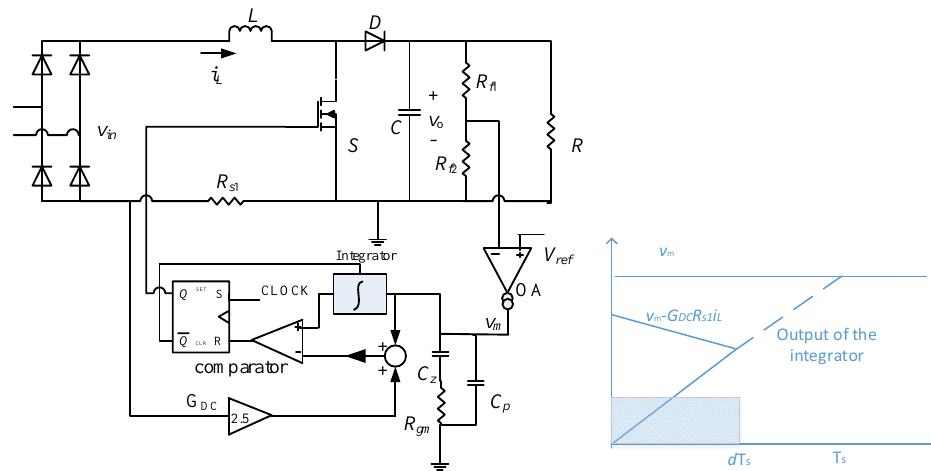
Figure 1. Circuit diagram of the OCC Boost PFC converter and its operating principle.